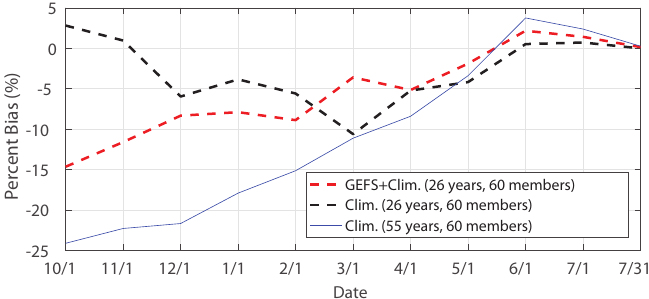
Figure 12. Percent bias (%) of the median forecasts from three different scenarios for